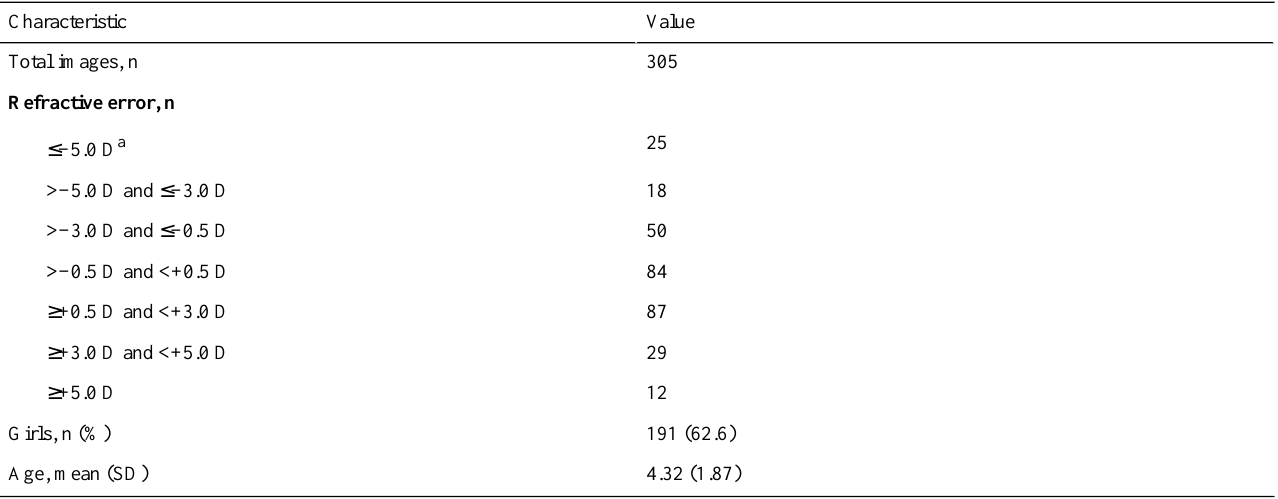
Table 2. Dataset participant